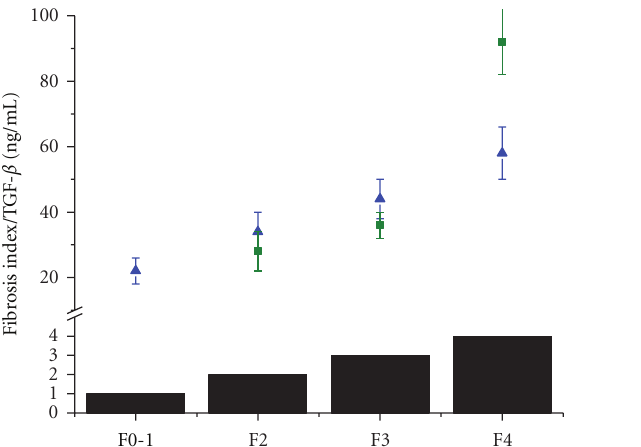
Figure 2: Correlation between the levels of TGF- β (ng/mL) in patients with HCV (triangle) and ALD (circle) and fibrosis score (solid black columns: fibrosis 0-1 (F0-1); fibrosis 2 (F2), fibrosis 3 (F3), cirrhosis